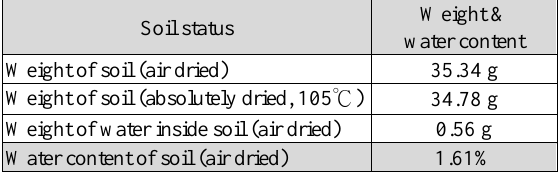
Table 4. Weight and water content of soil